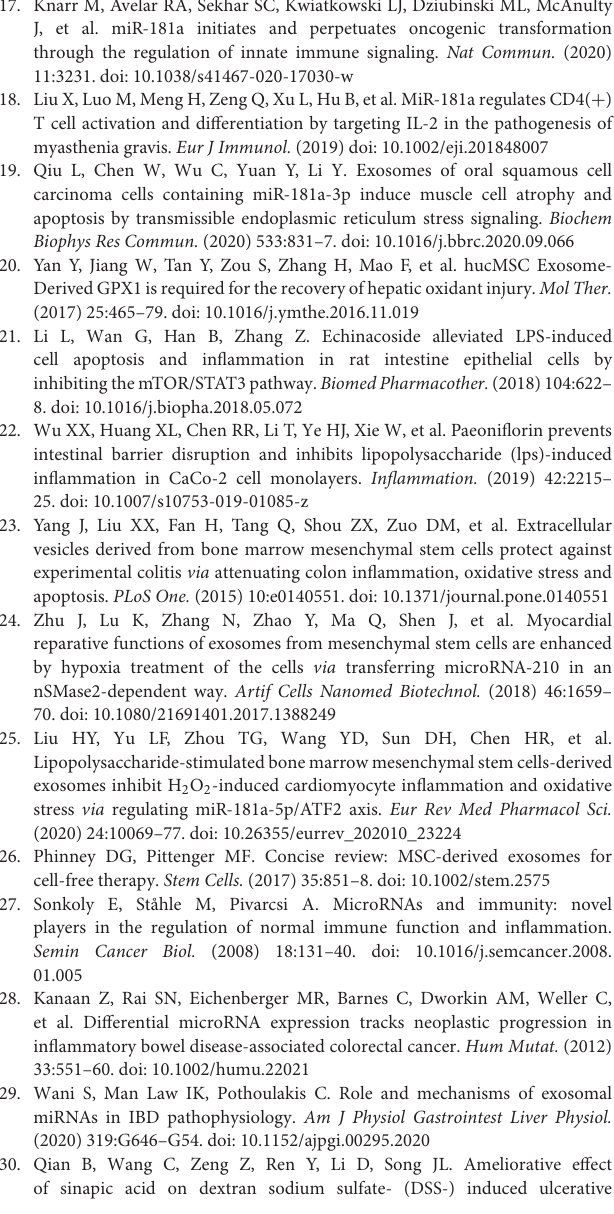
Supplementary Figure 1 | Validation of MSC-derived Exos. (A) The structure of Exos was observed via TEM. (B) Nanoparticle Tracking Analysis was used to identify exosomal diameter. (C) The expression levels of TSG101, CD81, and CD63 were detected via Western blotting. (D) The absorbance of MSC-derived Exos by HCOEPICs. (E) The expression of MSC-derived exosome miR-181a was detected by qRT-PCR. (F) qRT-PCR was used to detect the expression levels of MSC-derived exosomal miR-181a after transfection with miR-181a inhibitor. ∗ P < 0.05, vs. the Control. # P < 0.05, vs. the MSC-Exos